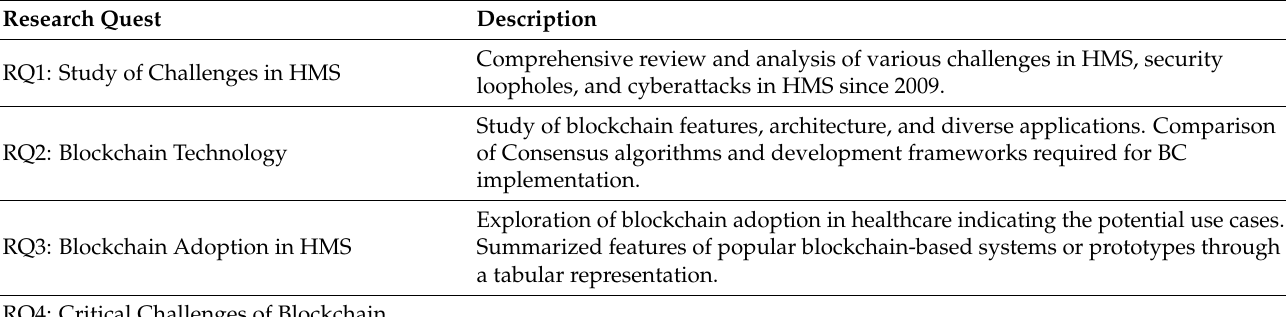
Table 2. Research quest used in review.